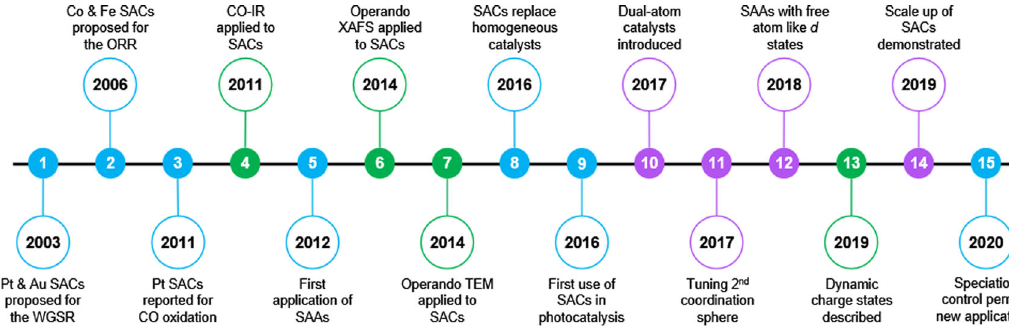
Fig. 1 The journey of single-atom catalysts 2